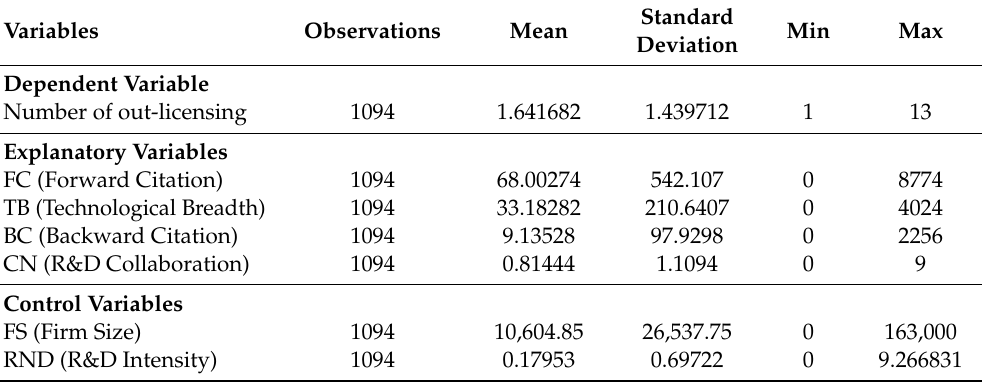
Table 1. Descriptive statistics of